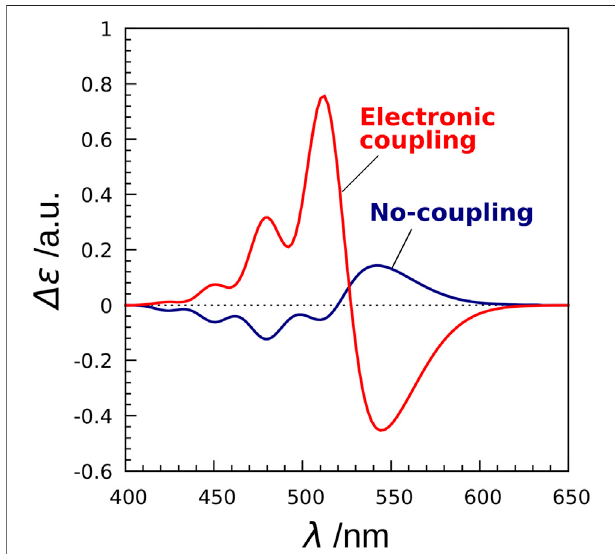
FIGURE 7 | CD spectra of XR calculated by the exciton model and the no-coupling model. The no-coupling model does not take into account the electronic couplings in the exciton